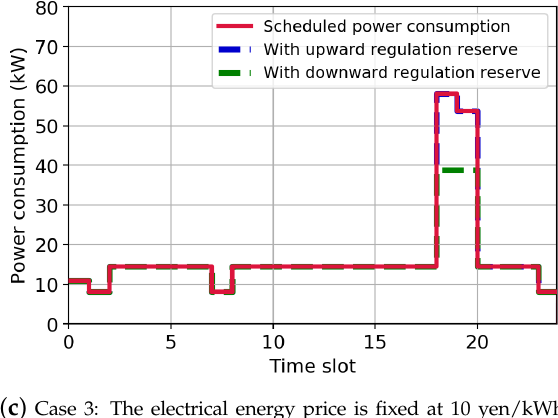
Figure 7. Results for the electrical power consumption of water pumps under the fixed electrical energy price. The solid red, dashed blue, and dashed green lines indicate the planned power consumption of the water pump, when upward regulation reserve capacity provided to the power system is fully activated and when downward regulation reserve capacity provided to the power system is fully activated, respectively.